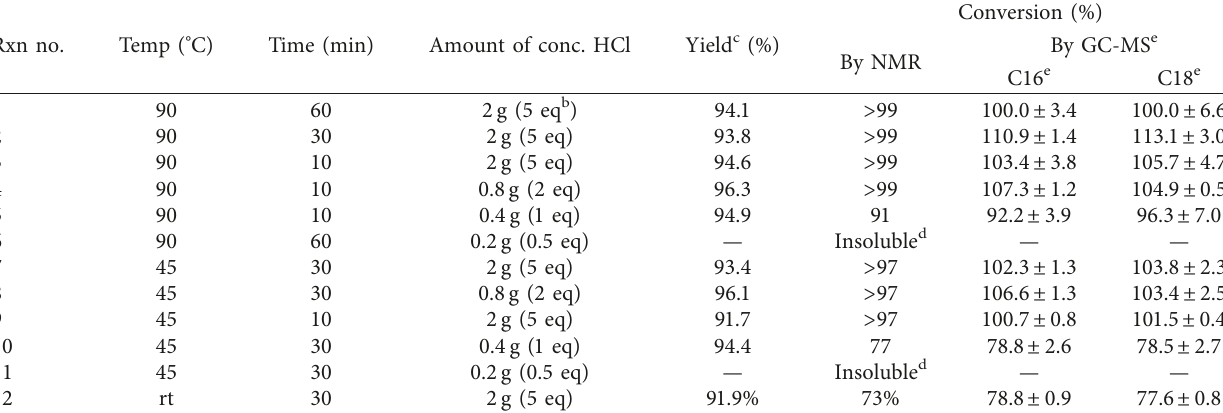
Table 2: Optimized conditions for preparation of FAMEs from zinc stearate a by acid-catalyzed esterification using the conc. HCl/methanol/ toluene method. Rxn